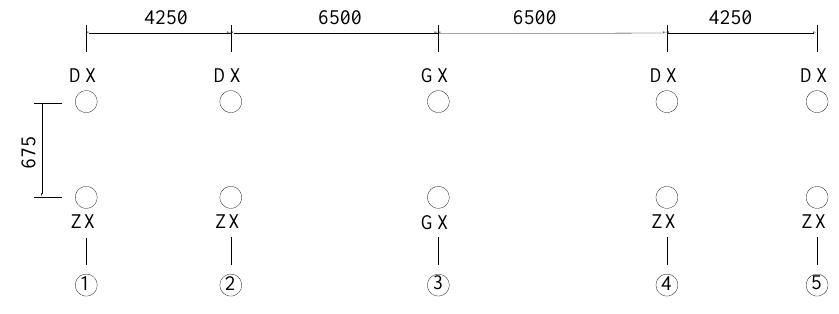
Figure 4. Bearing forms constraint of main bridge (unit: cm).